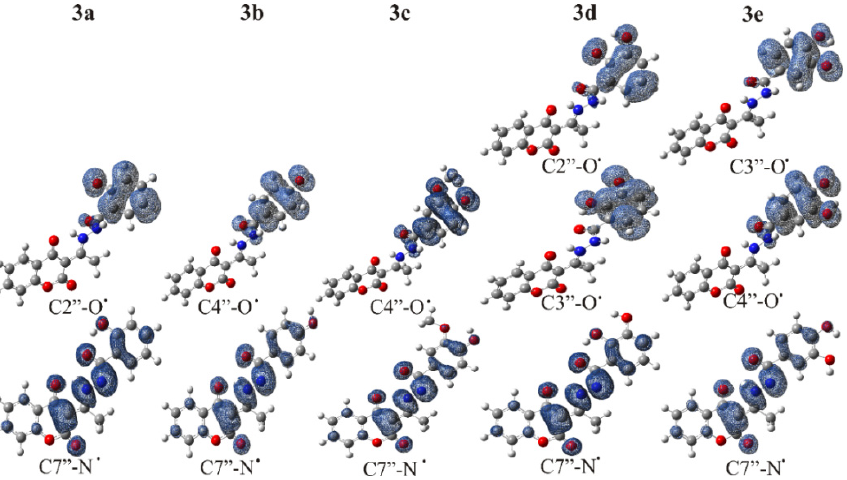
Figure 2. Spin density maps of the radicals obtained in the radical scavenging reactions of investi- gated compounds.